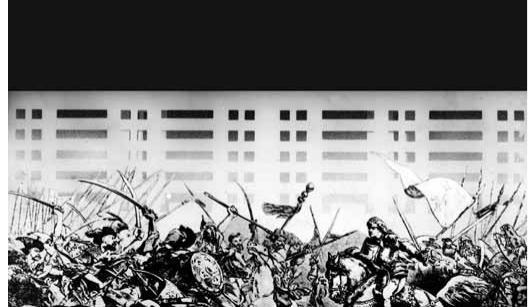
Fig. 13. Vision of a Barrier block (archit. Danas ruseckas, 1978)